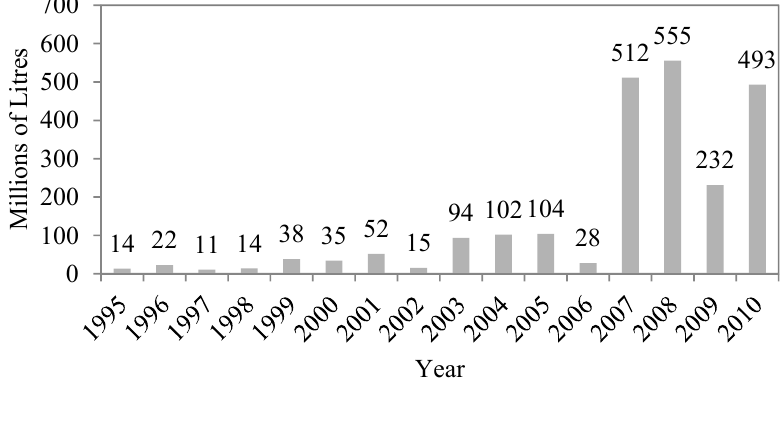
Figure 1. Canadian ethyl alcohol imports in millions of litres, 1995–2010